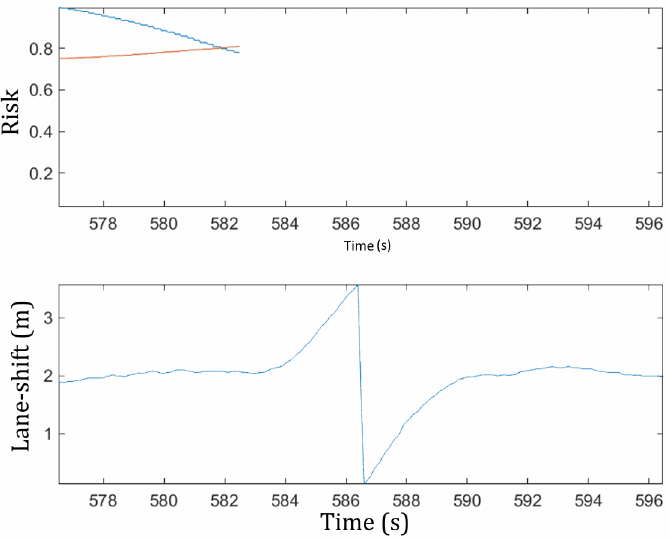
Figure 6. Evolution of the risk for the front vehicle (blue), the rear vehicle (red), and the lane shift of the ego-vehicle.